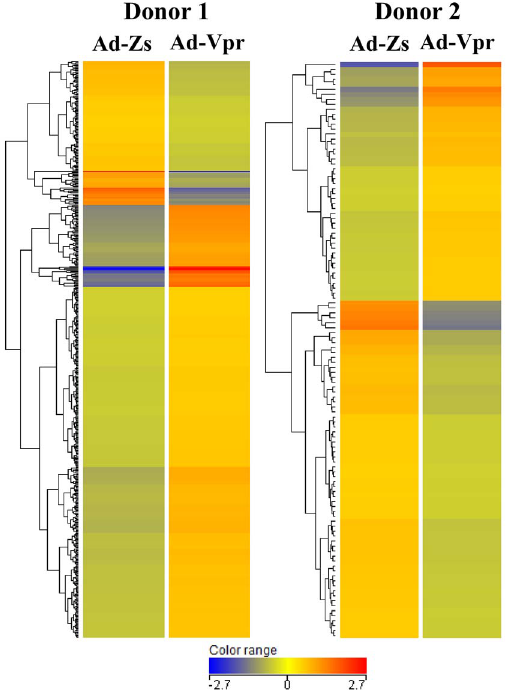
Figure 3. Differential expression profiling of cellular genes after infection with Ad-Vpr in human monocyte-derived macrophages (MDMs). Heat map of hierarchical gene clustering showing all genes that were either up- or down-regulated ( . 2-fold change) upon Ad-Vpr infection in MDMs from both donors. The color represents the normalized expression of genes in MDMs infected with Ad-Vpr or Ad-Zs (see color key). Gene up-regulation is denoted in red and gene down-regulation is denoted in